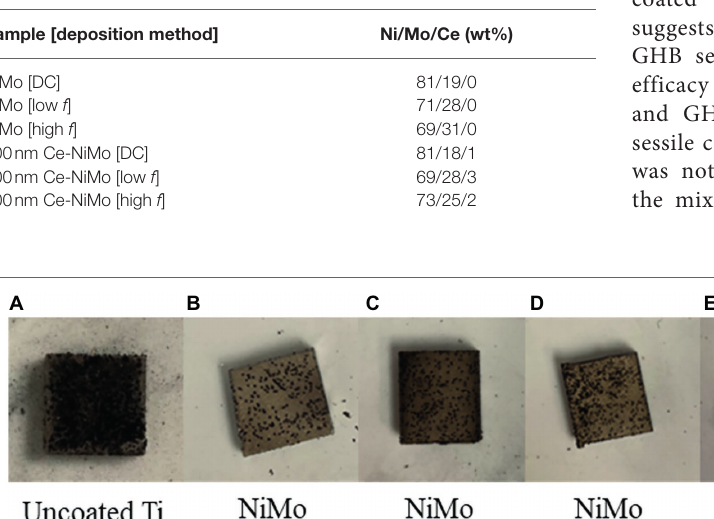
TABLE 2 | Compositions of NiMo and NiMo with CeO 2 NP inclusion